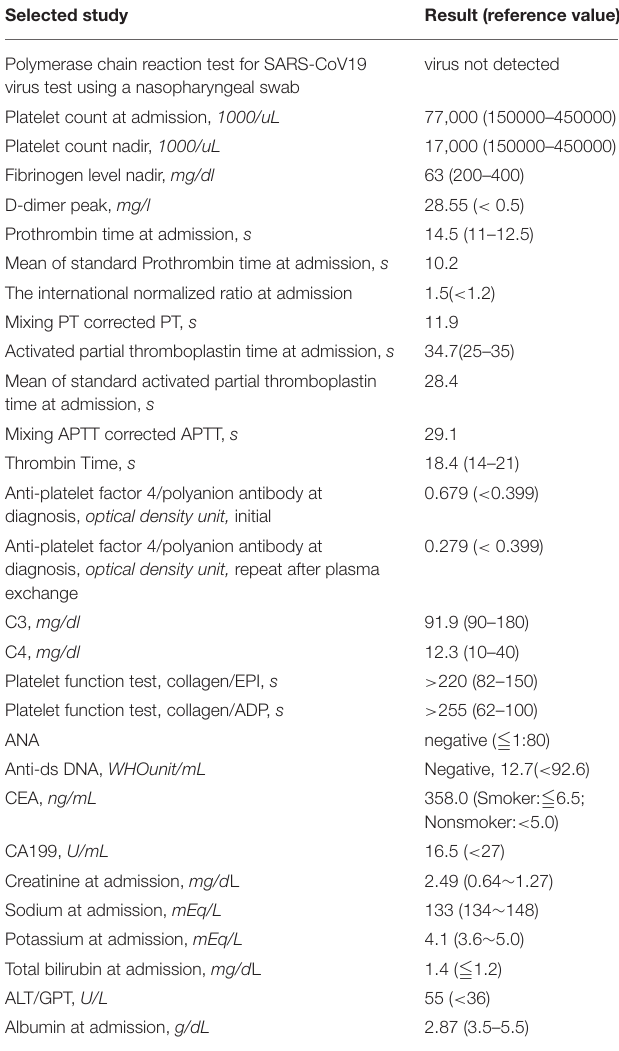
TABLE 1 | Laboratory